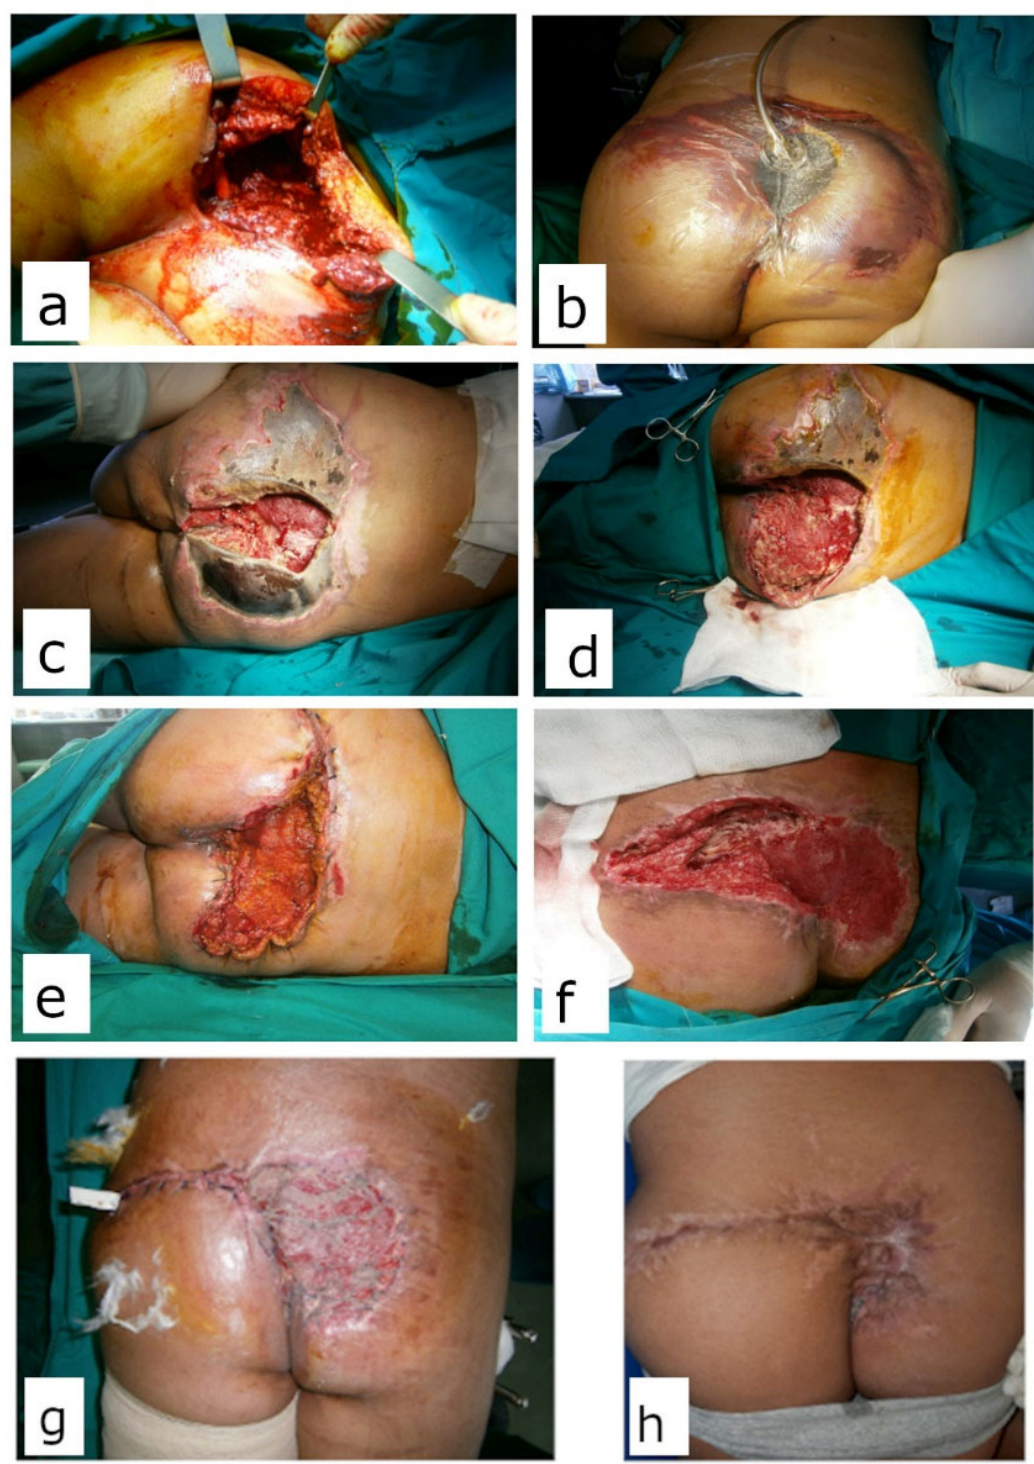
Figure 4. Twelve-year-old boy, hit by a train. ( a ) During primary debridement. Large soft tissue defect with decollement and exposed sacrum ( b ) Before first V.A.C. ® dressing change; ( c ) Large soft tissue necrosis during NPWT treatment. Mixed Gram+/ − flora was isolated; ( d ) Excisional debridement; ( e ) Definitive coverage of the wound on the left gluteus with direct sutures. Healthy granulations on the right gluteus; ( f ) Before definitive coverage of the right gluteus 56 days post injury and after 16 dressing changes; ( g ) Wound was covered with meshed STSG; ( h ) Three months after cov ‐ erage.